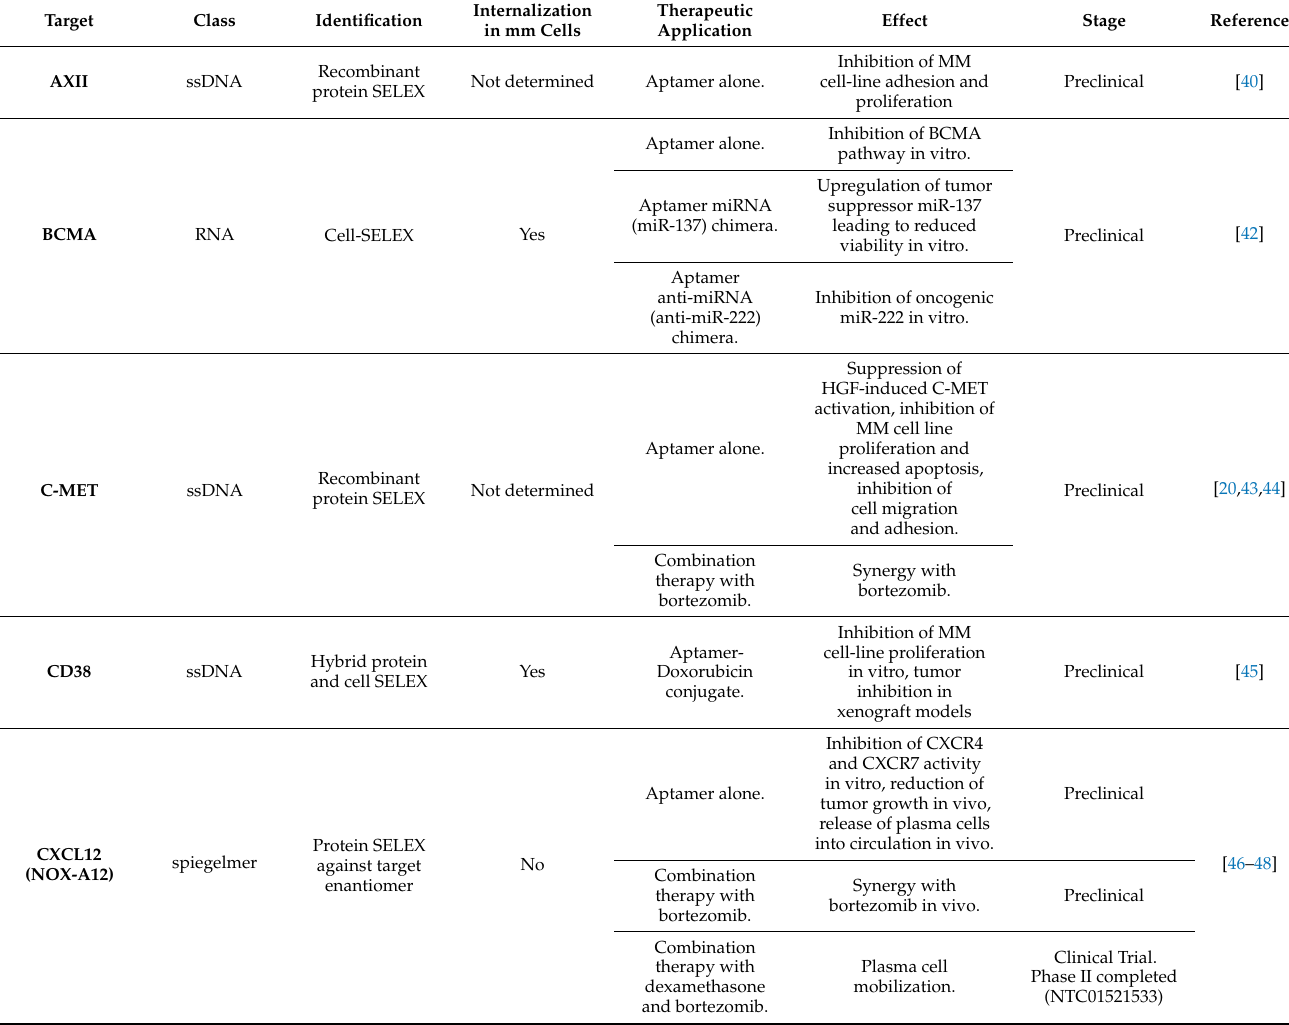
Table 2. Current aptamers for MM precision